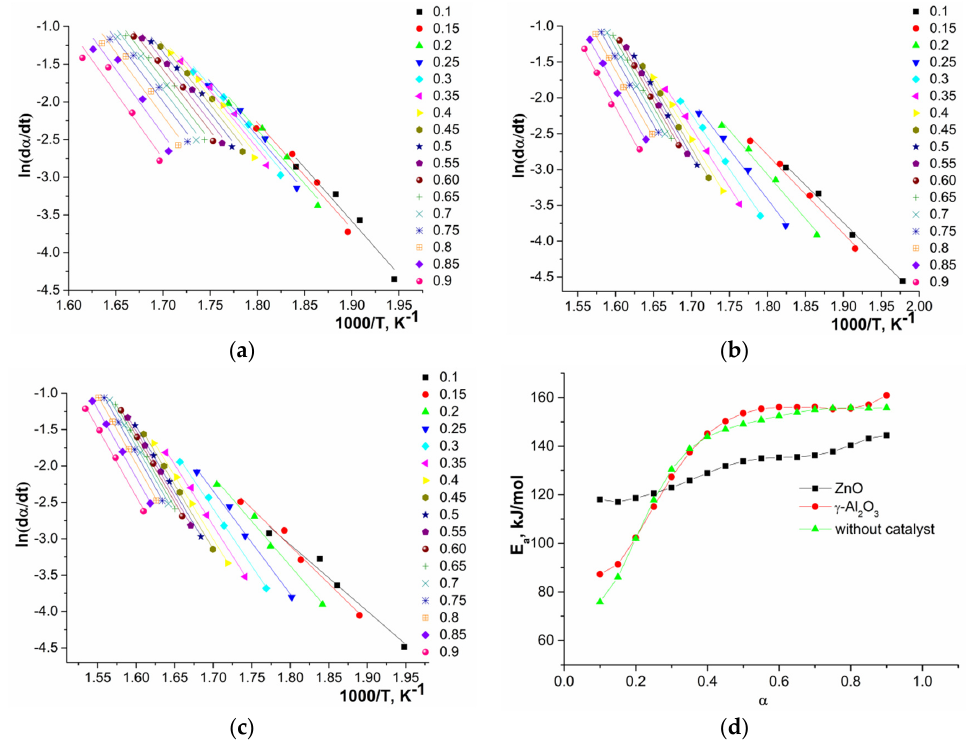
Figure 9. Dependences of ln(d α /d t ) on 1000/ Т for depolymerization in the presence of ZnO ( a ), γ -Al 2 O 3 ( b ), without catalyst ( c ), and of activation energy on conversion ( d ) calculated by FR method.